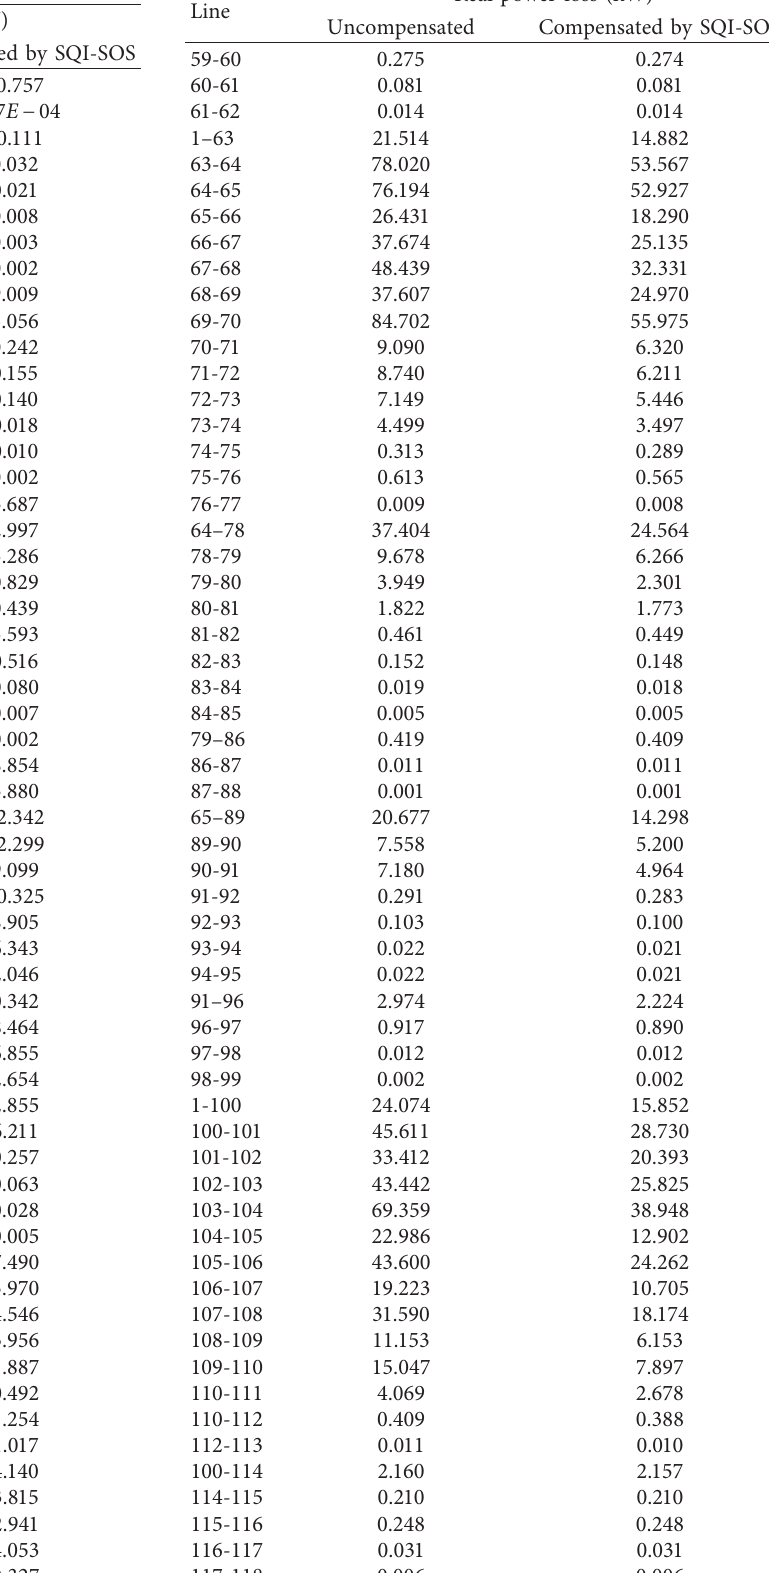
Table 16: Results of real power loss in all lines of the 119-bus system before and after the installation of